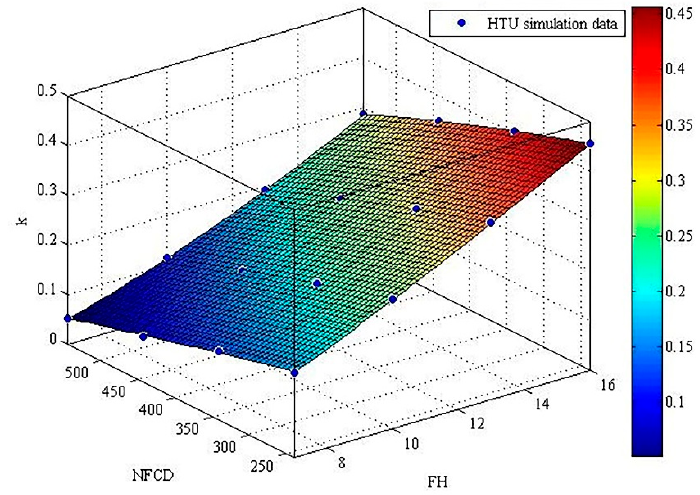
Figure 13. Fitting surface for the percentage of the air that can be calculated in PFHX performance calculation formulas ( k ).